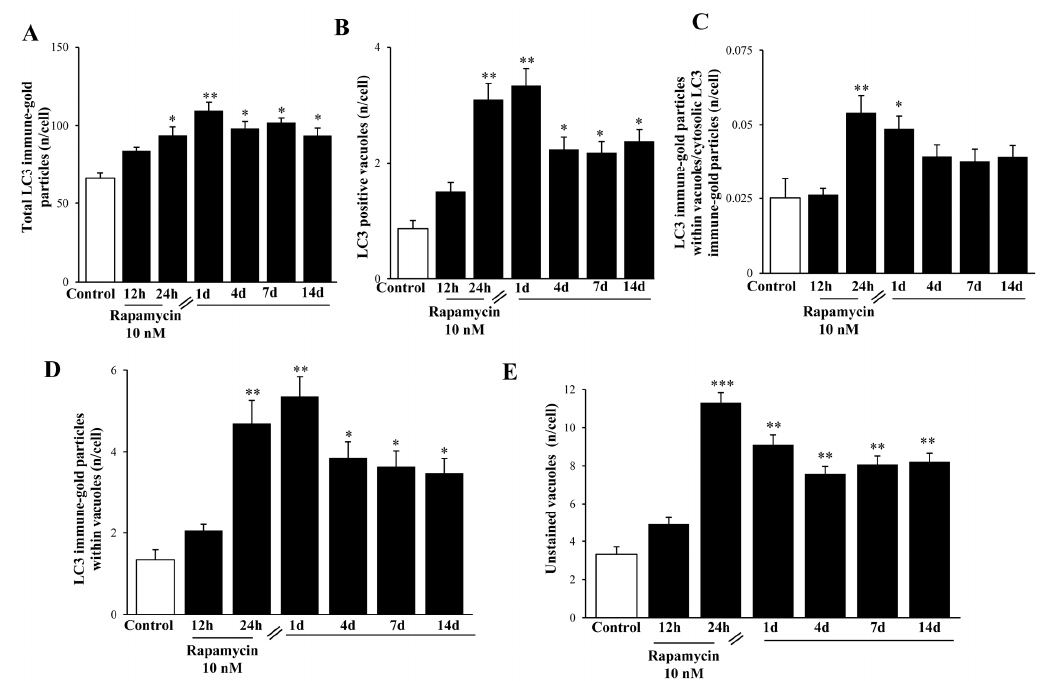
Figure 17. Rapamycin increases the amount of both LC3-stained and non-stained vacuoles within U87MG cells. LC3 immune-gold particles were increased by rapamycin within the cytosol ( A ) and vacuole compartments ( B ). The ratio of vacuolar/cytosolic LC3 was also increased by rapamycin ( C ), which also filled each LC3-positive vacuole with a higher stoichiometric density of LC3 proteins ( D ). Rapamycin increases the vacuolar compartment also considering those vacuoles which do not stain for LC3 ( E ). Values were obtained from 50 cells per group. * p ≤ 0.05 vs Control; ** p ≤ 0.05 vs Control and 12 h rapamycin; *** p ≤ 0.05 vs all other groups.